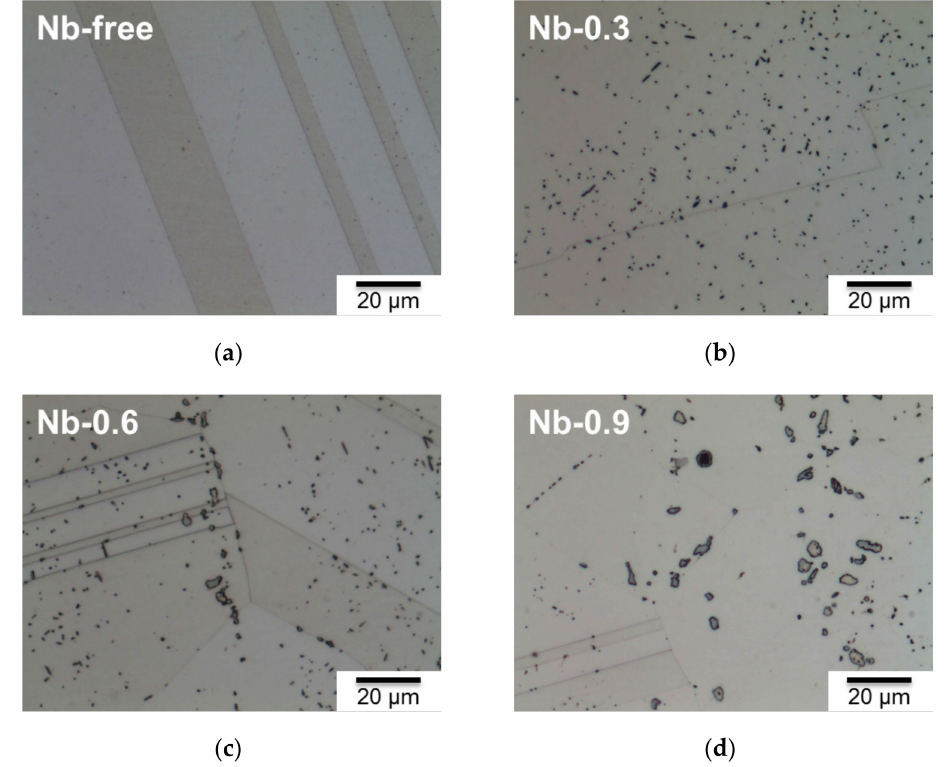
Figure 1. Optical microstructure and precipitate morphology of 22Cr25NiWCuCo(Nb) steel specimens after heat treatment at 1200 ◦ C for 2 h: ( a ) Nb-free, ( b ) Nb-0.3, ( c ) Nb-0.6, and ( d ) Nb-0.9 steel